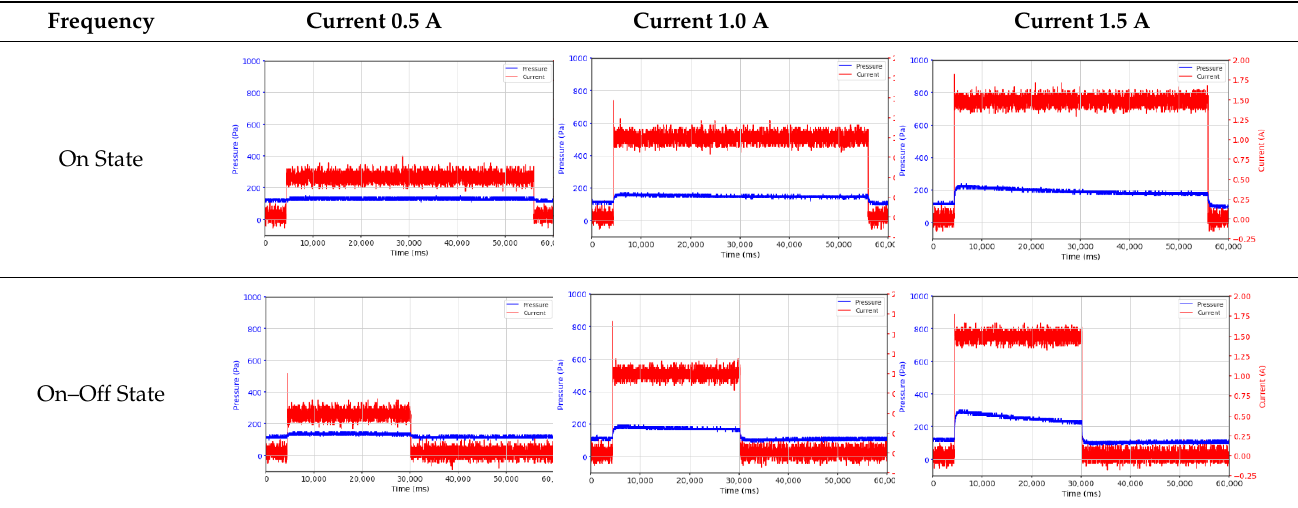
Table 2. Comparison of the results of observations of pressure strength on variations in current and frequency of magnetic field application on the MRF.